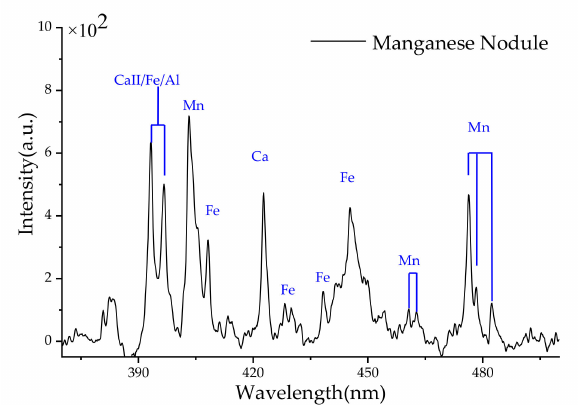
Figure 5. Typical spectra of a manganese nodule sample from deep sea in Jiaozhou